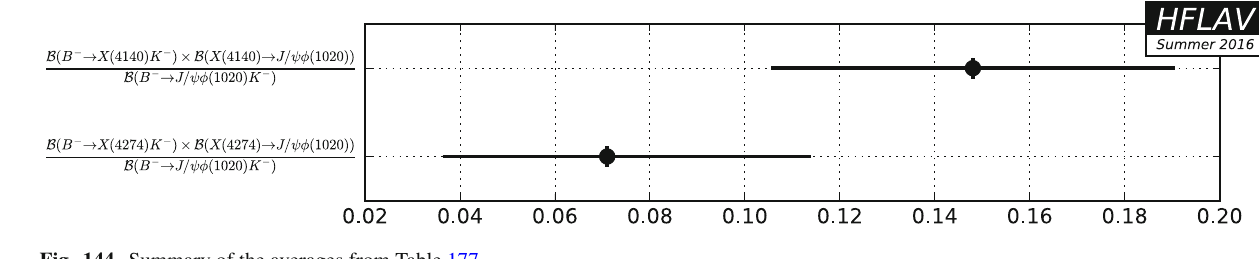
Fig. 144 Summary of the averages from Table 177